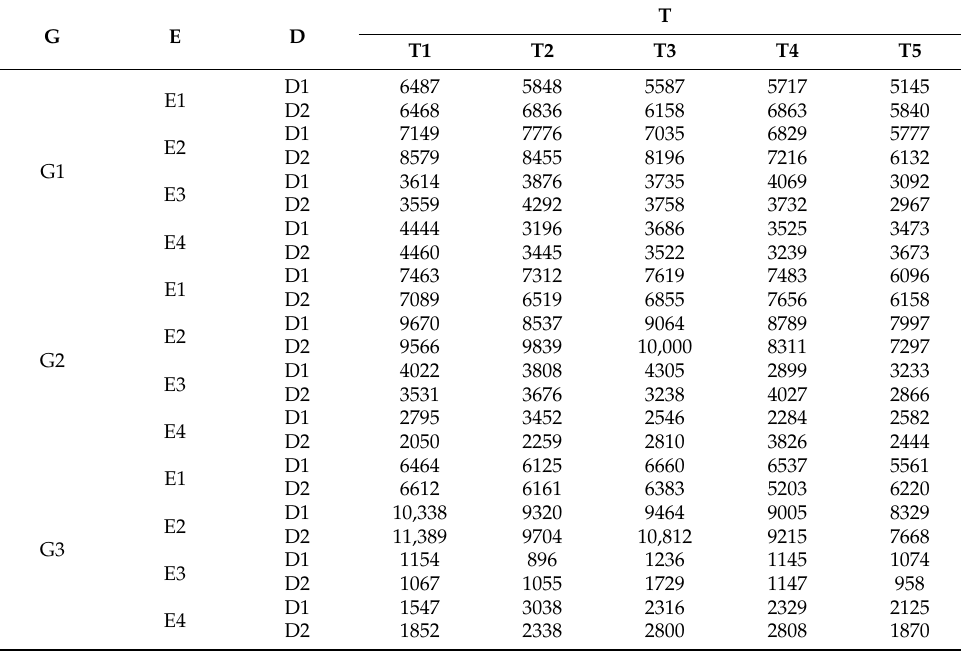
Table 4. Average yield (kg/ha) of three maize inbreed lines grown in four year–location interactions in two densities for five defoliation treatments.